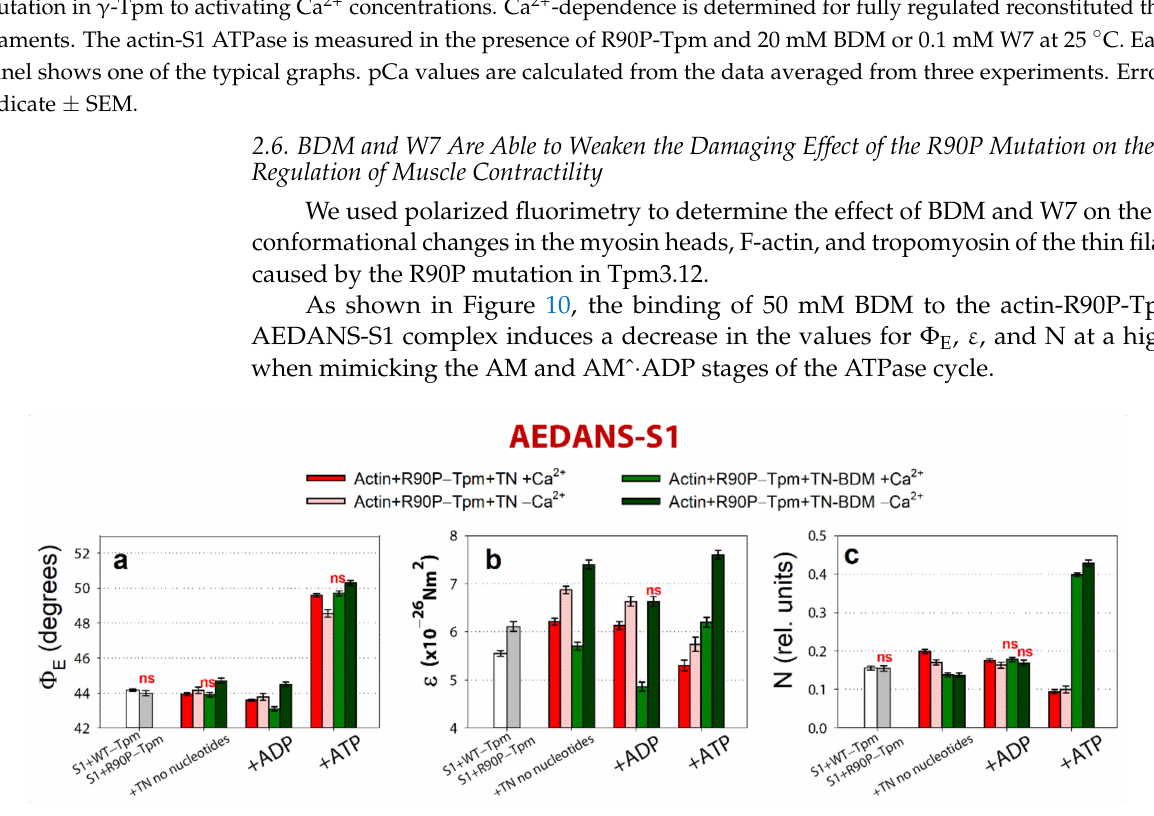
Figure 10. The effect of troponin and Ca 2+ on the values of Φ E ( a ), ε ( b ), and N ( c ) of the polarized fluorescence of 1,5-IAEDANS bound to S1 (AEDANS-S1), in the absence and in the presence of 50 mM BDM, revealed in ghost fibers containing R90P-Tpm under conditions simulating the sequential steps of the actomyosin ATPase cycle. The experimental conditions and designations are described in Materials and Methods. The data represent the mean values for 5–7 fibers for each experimental condition. The Φ E , ε , and N values in the absence of TN and in the presence of Ca 2+ and nucleotides are significantly altered by BDM ( p < 0.05). The index “ns” indicates statistically insignificant differences in the values of Φ E , ε , and N between the mutant tropomyosin in the absence or presence of BDM. Error bars indicate ±